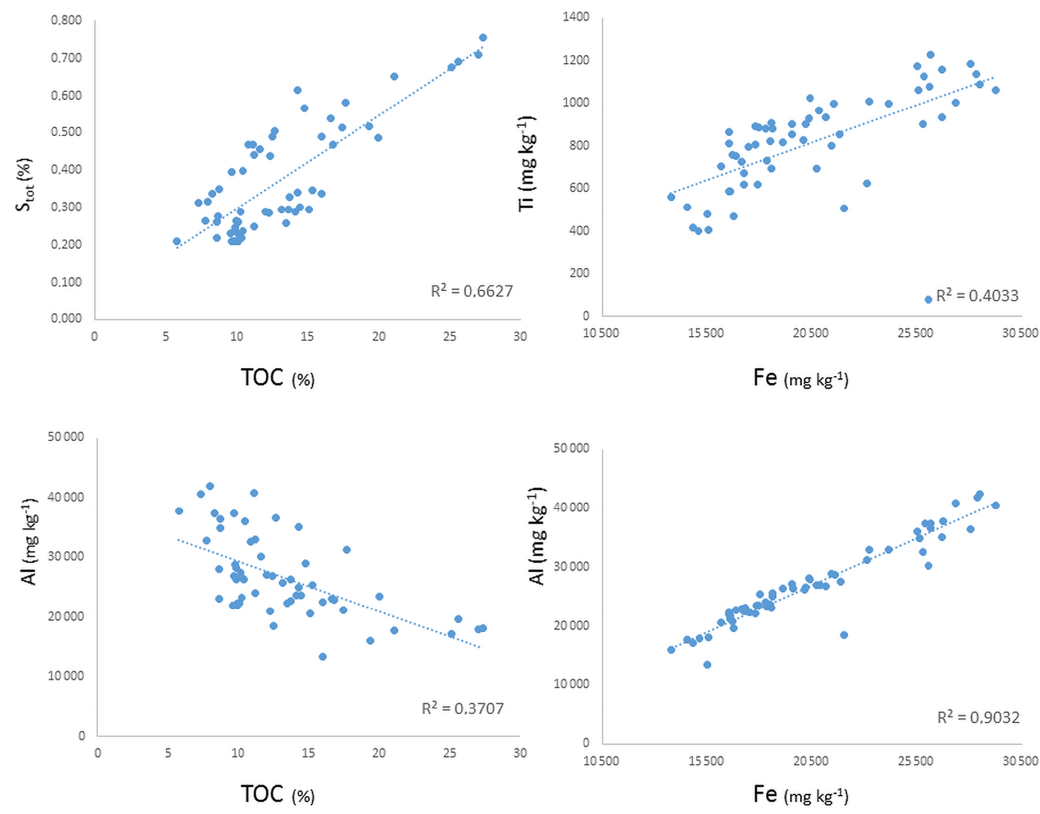
Figure 7. Scatter plot showing the correlation in the core M1 between S and TOC, Al and TOC, Ti and Fe, and Ti and Fe (drawing: Anna